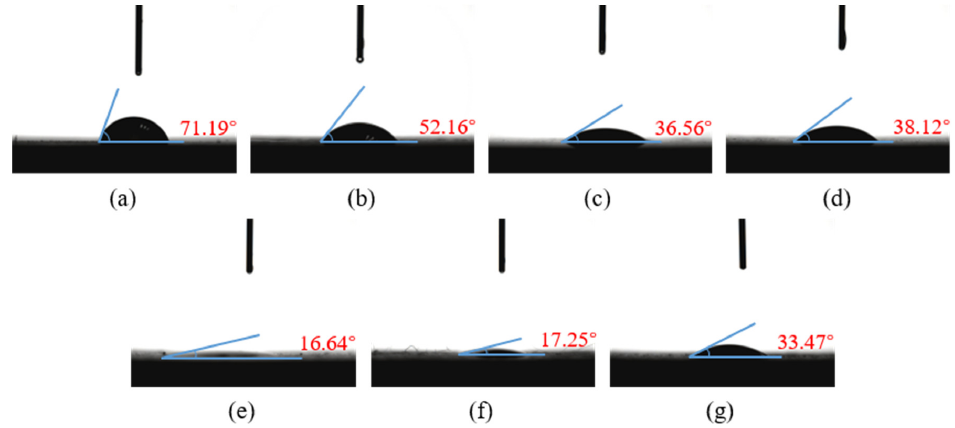
Figure 12. Morphological diagram of ethylene glycol droplets on the surface of CF/EP with different treatment methods.